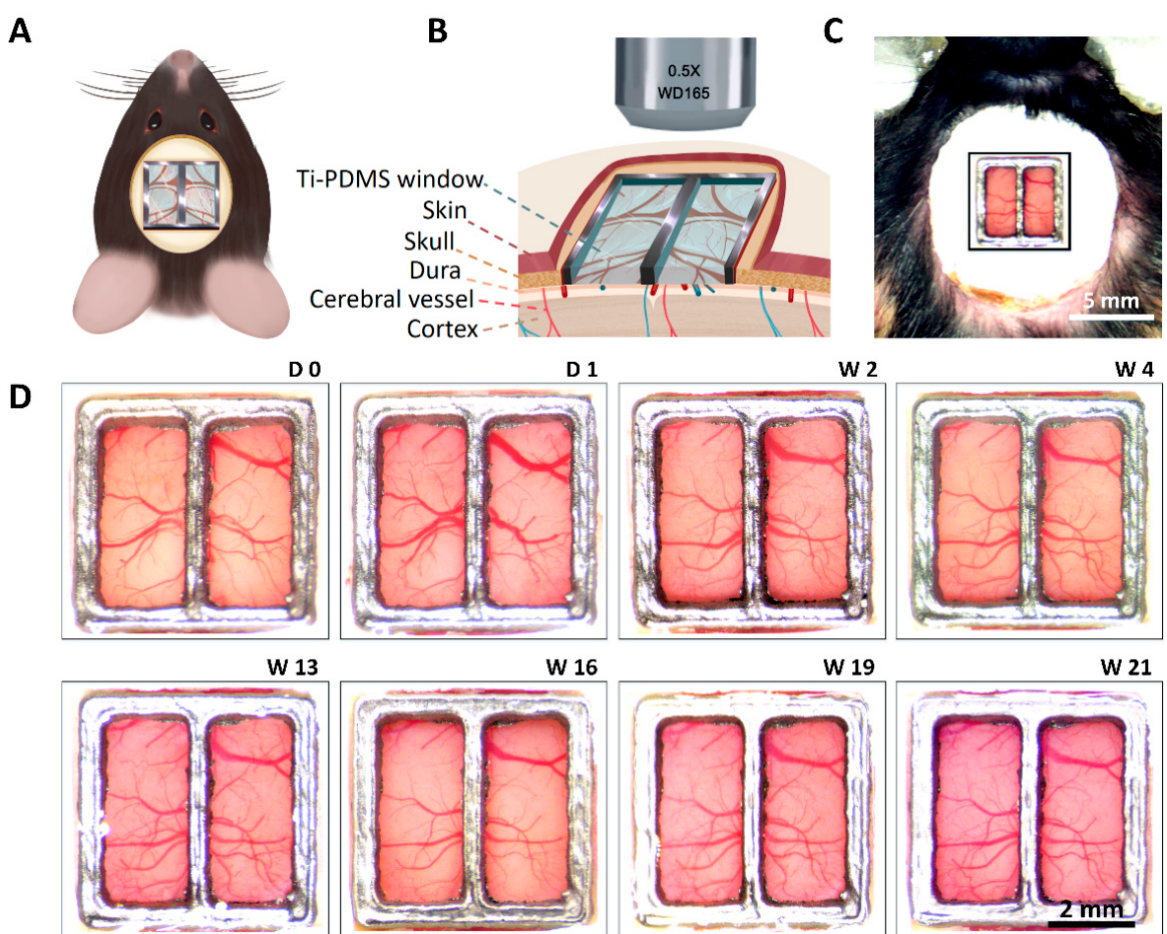
Figure 6. Implantation and functional evaluation of chronic Ti-PDMS cranial window. ( A ) Schematic diagram of a rodent with Ti-PDMS cranial window. ( B ) Schematic cross-section of a rodent with Ti-PDMS cranial window. ( C ) A typical photograph of one C57BL/6 mouse with Ti-PDMS cranial window. ( D ) Cortical images of the Ti-PDMS cranial window at D 0, D 1, W 2, W 4, W 13, W 16, W 19 and W 21